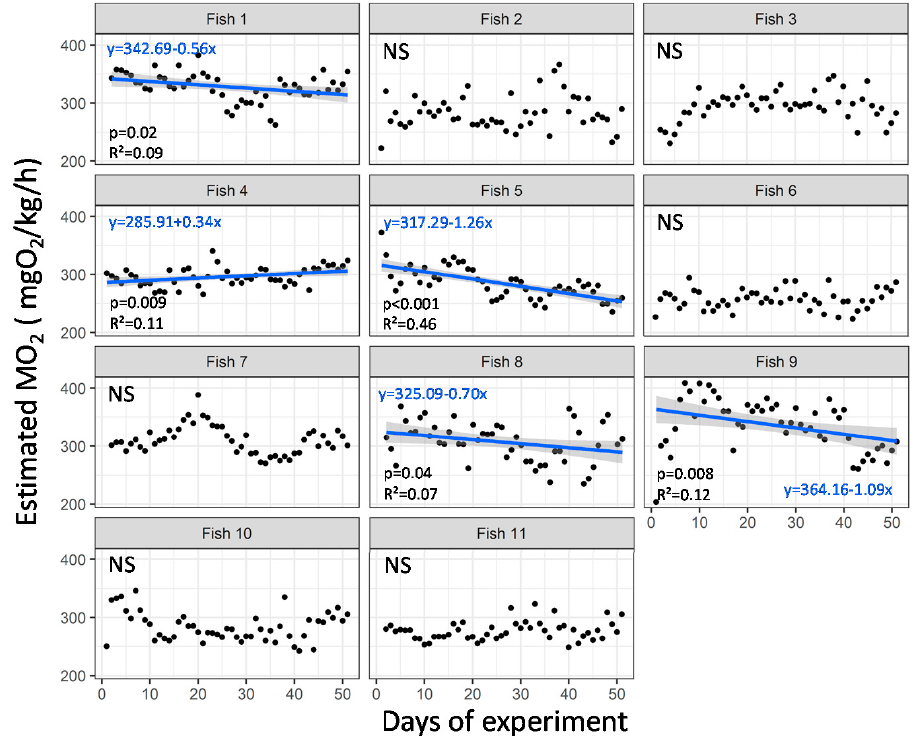
Figure 7. Mean of the daily estimated oxygen consumption rate (MO 2 , mgO 2 /kg/h) of implanted rainbow trout ( Oncorhynchus mykiss ) over the experimental period in aquaculture facility. The blue line represents a significant variation over time, and the grey shape represents the 95% confidence interval. R 2 and p value and the coefficient of the regression are indicated for each significant linear regression ( p < 0.05). Otherwise, NS (not significant) is indicated for each fish (n = 11 implanted fish).